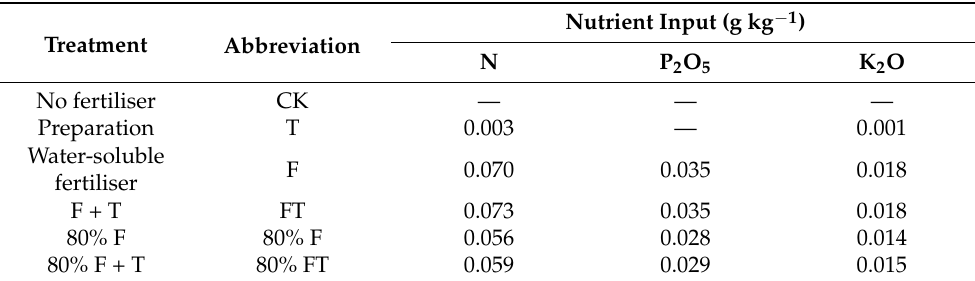
Table 1. Nutrient inputs of topdressing